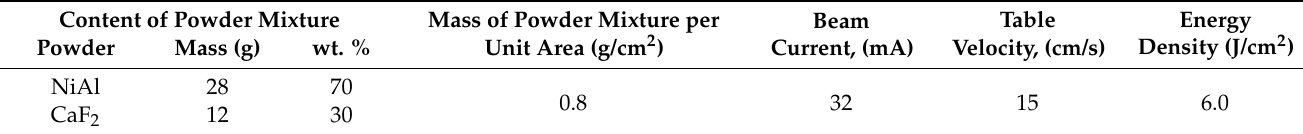
Table 2. The regimes of the non-vacuum electron beam surfacing. Content of Powder Mixture Mass of Powder Mixture per